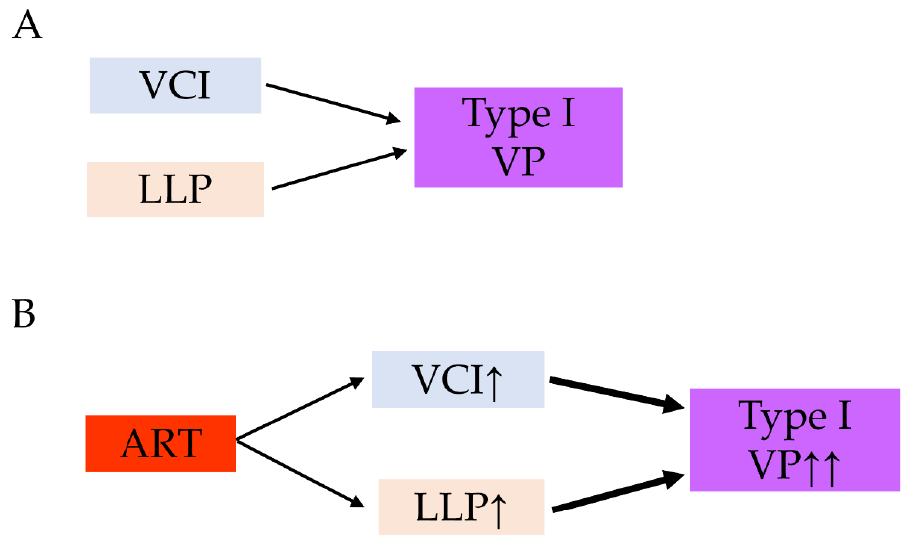
Figure 7. Our hypothesis behind the possible mechanism of the increased rate of vasa previa in ART pregnancies. ( A ) The combination of VCI and LLP is a high-risk condition of vasa previa. ( B ) ART pregnancy is associated with increased rate of VCI and LLP compared to non-ART pregnancy. The increased rate of VCI and LLP may lead to increased rate of type I vasa previa. Abbreviations: ART, assisted reproductive technology; VCI, velamentous cord insertion; VP, vasa previa; LLP, low-lying placenta; ↑ , increase; ↑↑ , markedly increase.